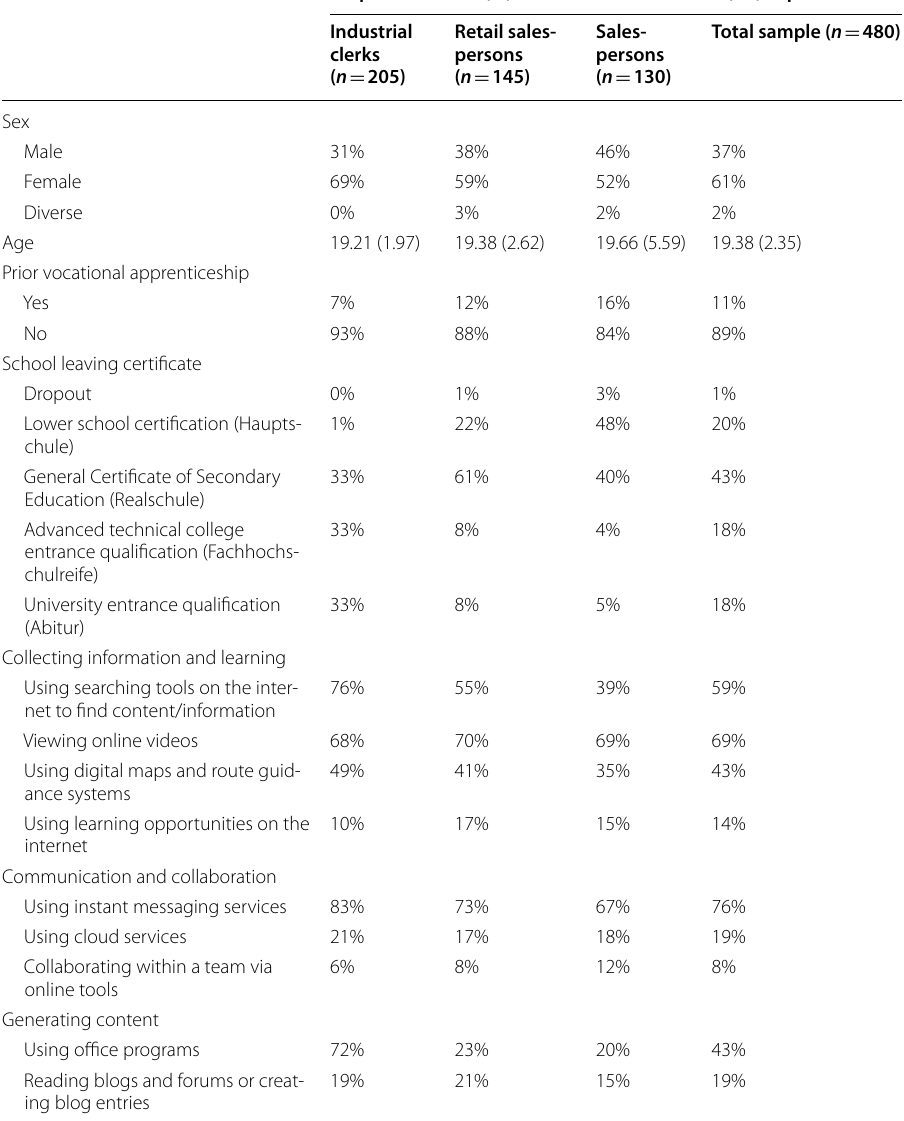
480) = Proportion/mean ( M ) with standard deviation ( SD ) in